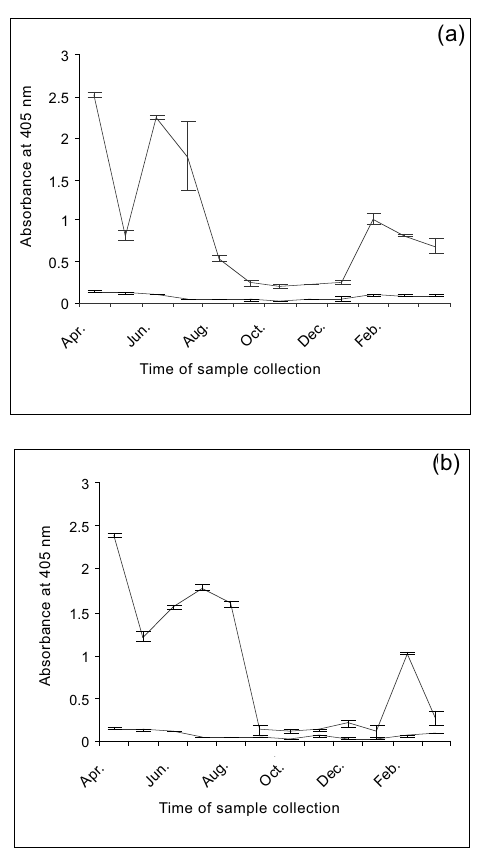
Fig. 3. Average monthly absorbance (A ) and stand- 405nm ard error values of sap extracted from tissues of peach cultivars: (a) Baby Gold and Elberta; and (b) Red Ha- ven, infected with Prunus necrotic ringspot virus in 2001–2002 in the Tafila area. Baselines are the average of the healthy monthly A 405nm